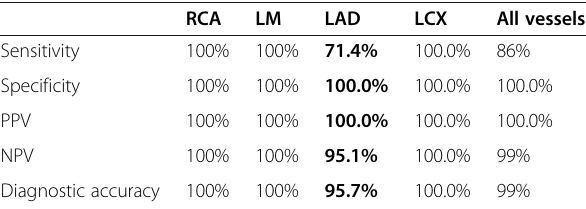
Table 4 Accuracy of CCTA for the diagnosis of significant stenosis in each (and overall) coronary artery per-vessel analysis RCA LM LAD LCX All